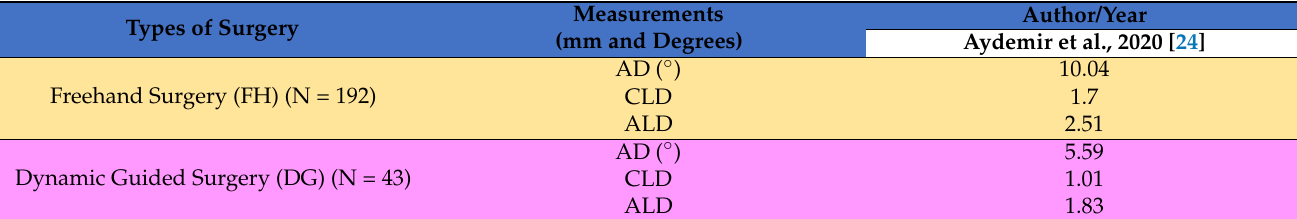
Table 3. Measurements in freehand surgery VS. dynamic guided